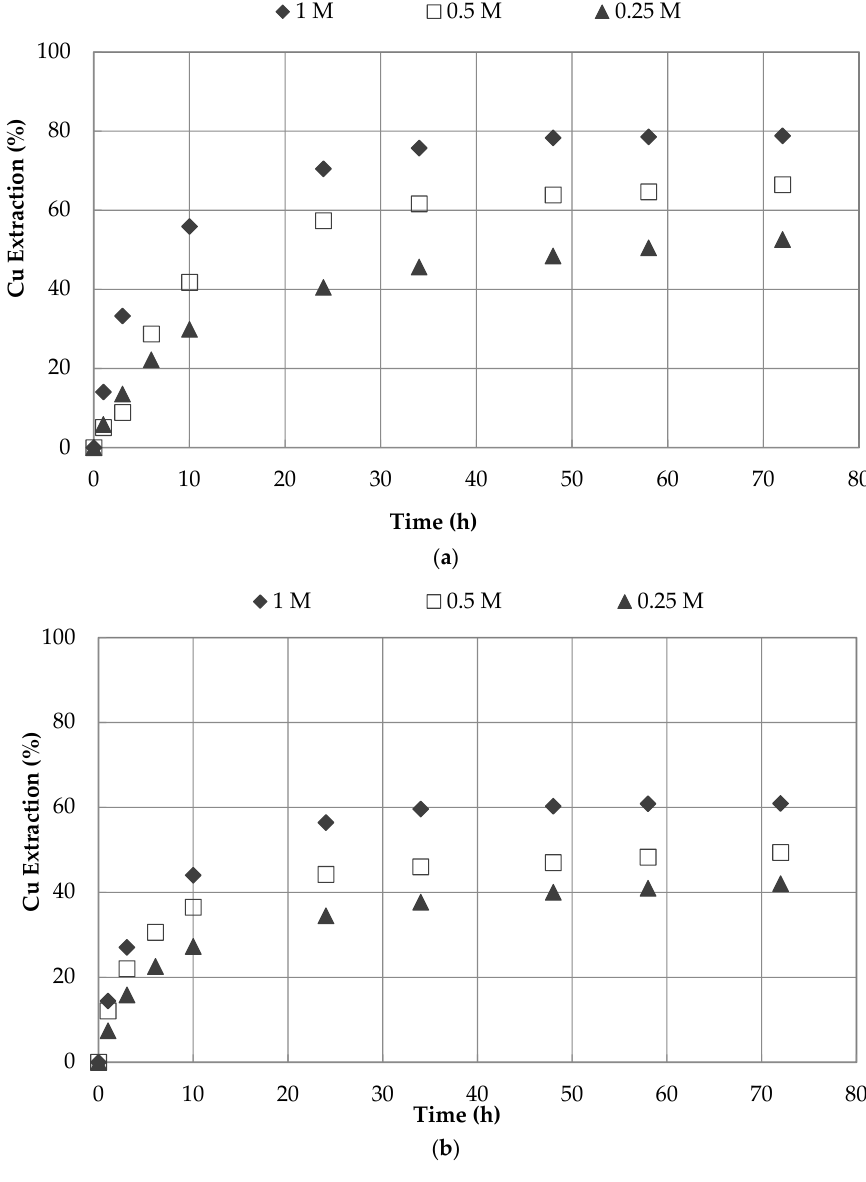
Figure 4. Effect of sulfuric acid concentration on copper extraction using NaNO 3 (1 M), 3 days of leaching and 45 °C: ( a ) seawater and ( b ) water.